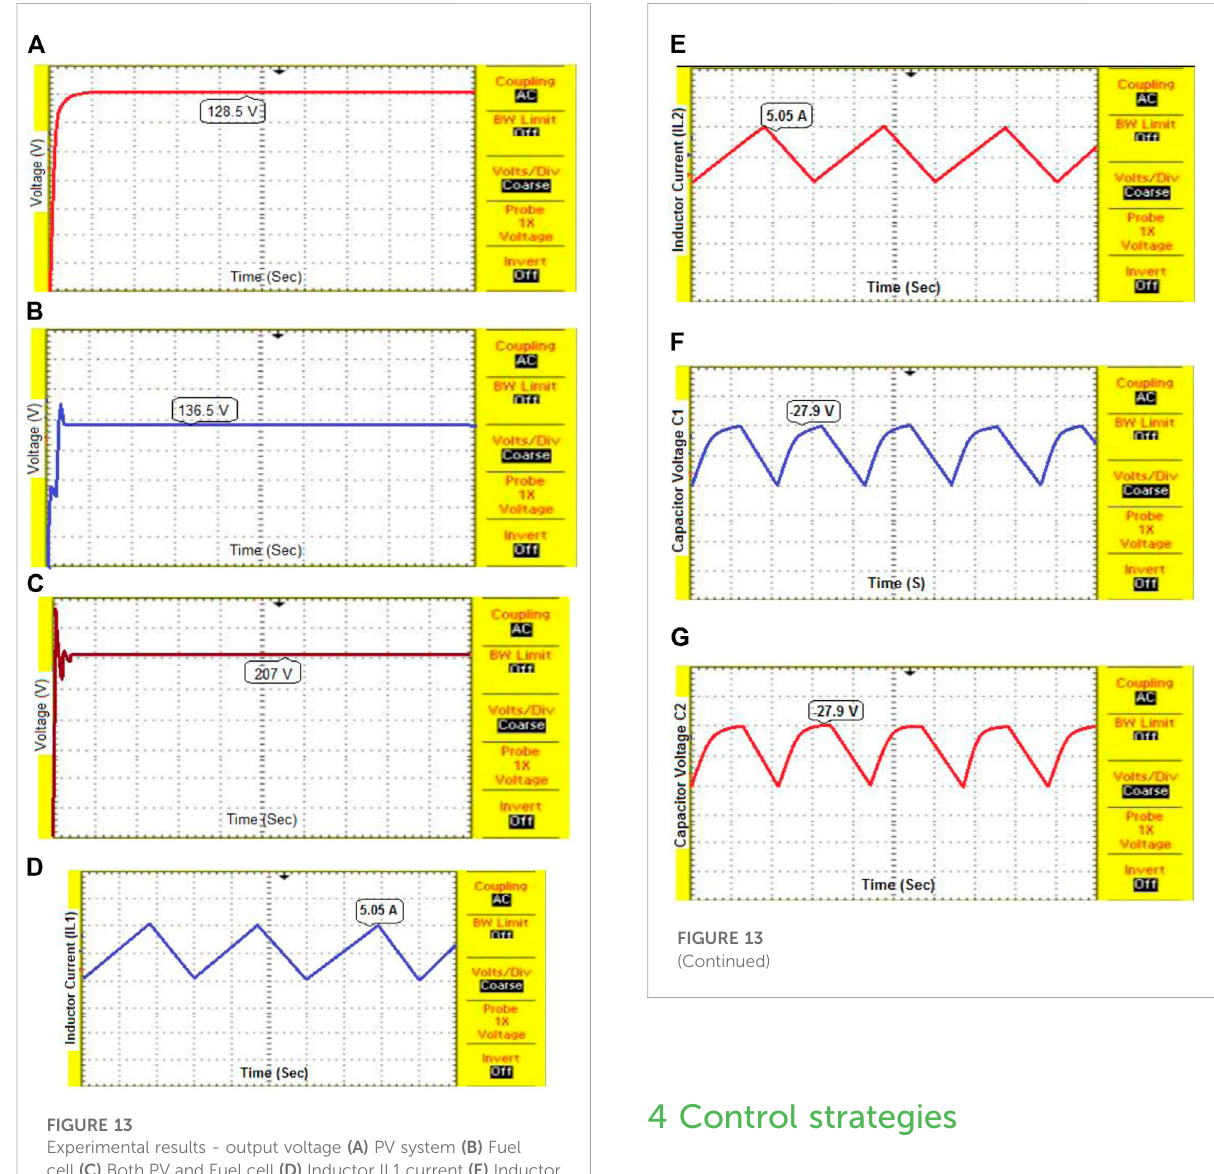
FIGURE 13 Experimental results - output voltage (A) PV system (B) Fuel cell (C) Both PV and Fuel cell (D) Inductor IL1 current (E) Inductor IL2 current (F) voltage across capacitor VC1 (G) Voltage across capacitor